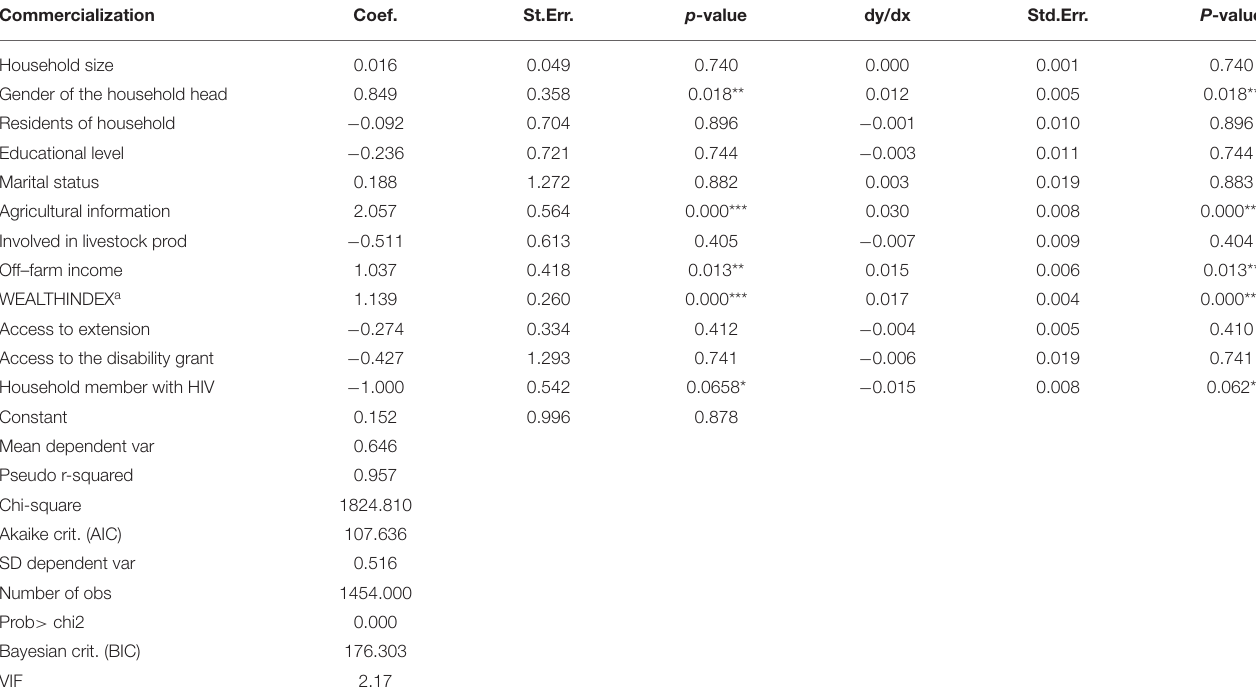
TABLE 7 | Probit results for determinants of commercialization of indigenous crops.